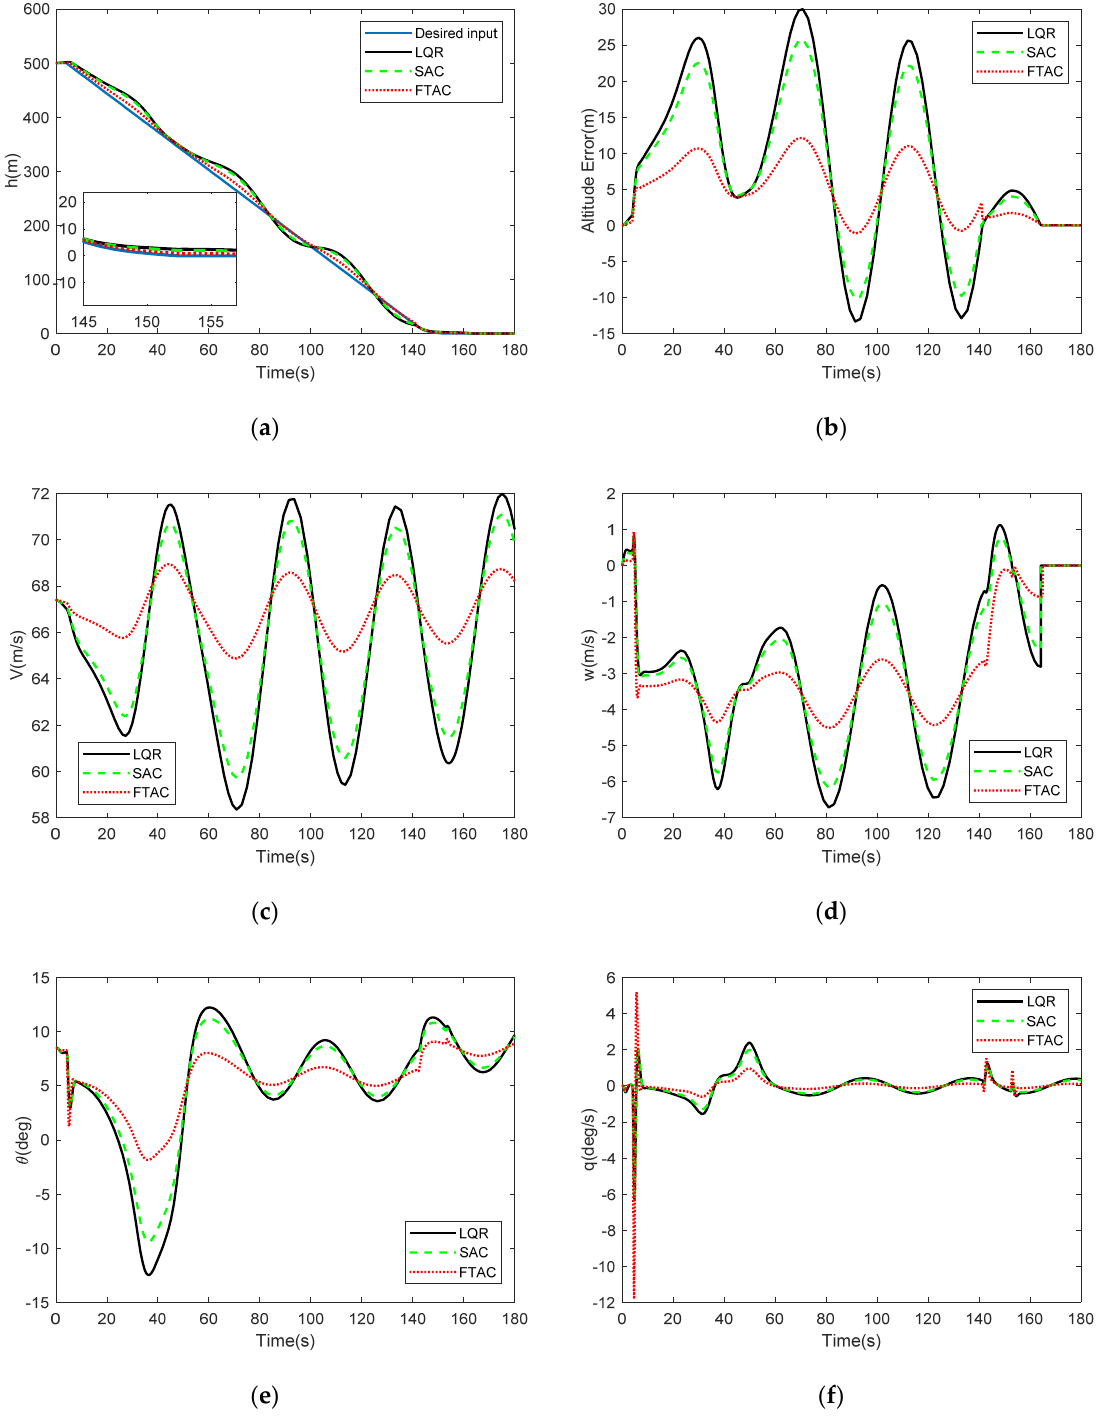
Figure 10. Scenario 2–Landing in Windshear. ( a ) Altitude response ( b ) Altitude error. ( c ) Velocity response ( d ) Descent rate response. ( e ) Pitch angle response. ( f ) Pitch rate response.